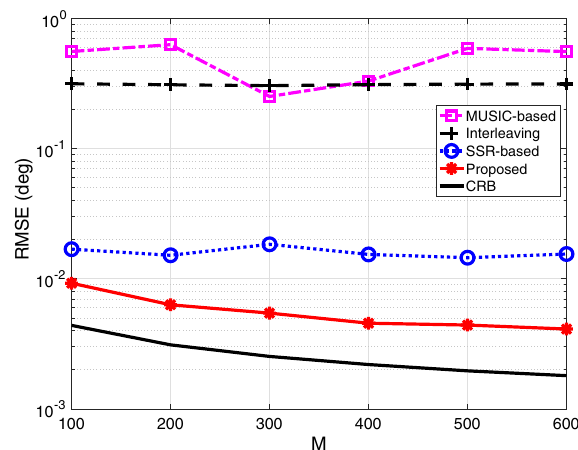
Fig. 4 DOA estimation accuracy comparison with different number of OFDM symbols